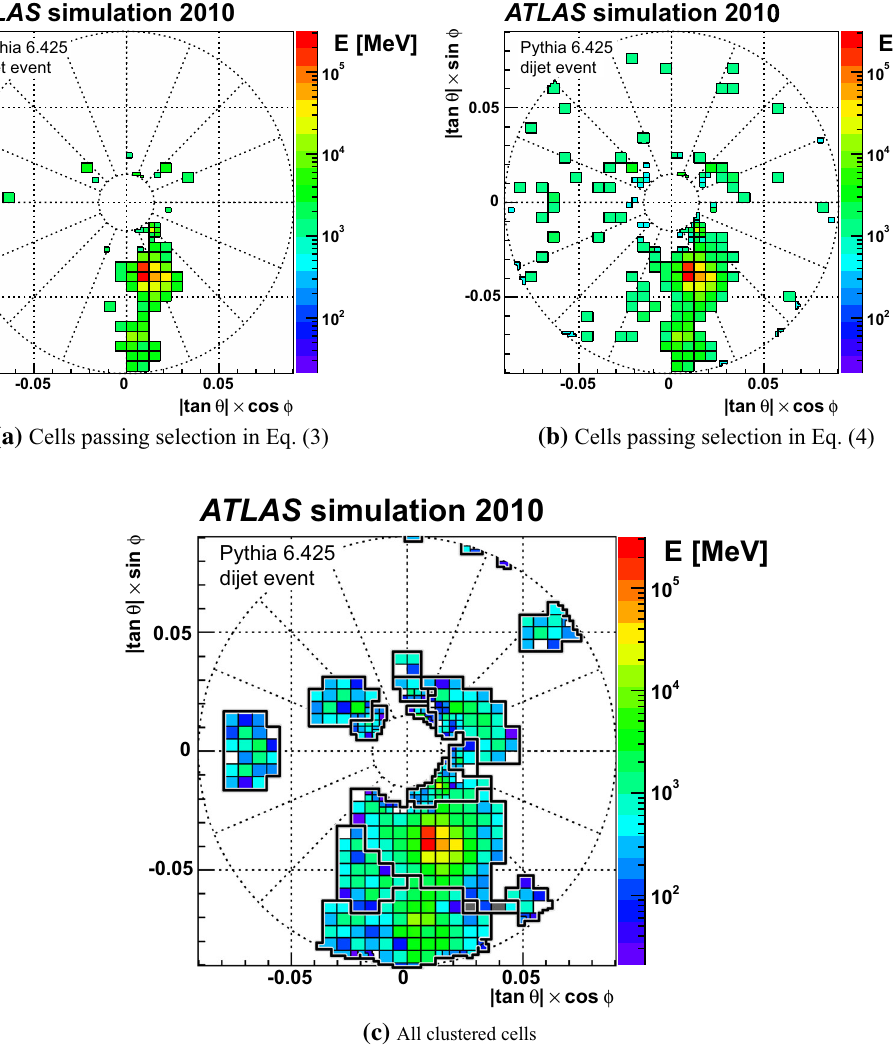
Fig. 6 Stages of topo-cluster formation in the first module ( FCAL0 ) surrounding it. Pile-up is not included in this simulation, but electronic noise is modelled. Cells not colour coded but inside a topo-cluster have of the FCAL calorimeter for a simulated dijet event with at least one a negative signal, while cells shaded grey are completely surrounded jet entering this calorimeter. Shown in a are cells with signal signifi- | > 4 that can seed topo-clusters, in b cells with | ς EM | > 2 by clustered cells but not part of a topo-cluster themselves. The cell and cance | ς EM cell cell cluster boundaries are displayed on a dimensionless grid using the polar controlling the topo-cluster growth, and in c all clustered cells and the angle θ and the azimuthal angle φ . This view maintains the cell shapes outline of topo-clusters and topo-cluster fragments in this module. All and proportions. For the definition of the cell signal significance ς EM clusters shown in c which do not contain a seed cell from this mod- ule are seeded in other modules of the FCAL , or in other calorimeters see Eq.